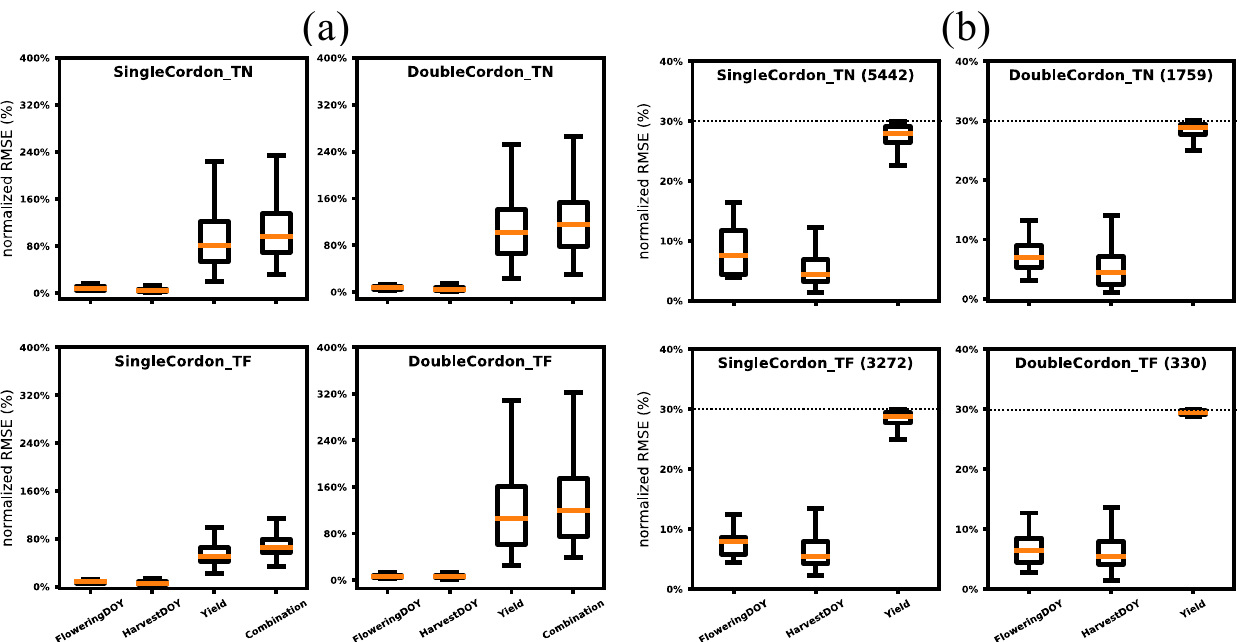
Figure 1. Spread of the STICS model prediction uncertainties (nRMSE, %) for each variety–training system on flower and harvest DOY, yield (kg/ha) and the objective function (combined phenology and yield), respectively. Spread over ( a ) all the tested parameter vectors (684,375 effective combinations); and ( b ) selected parameter vectors resulting in an nRMSE (%) below 30% (dash line), where the figures in the brackets indicate the corresponding number of available vectors. Refer to Figure S2 for the boxplot definition. TN: Touriga Nacional; TF: Touriga Franca (TF).